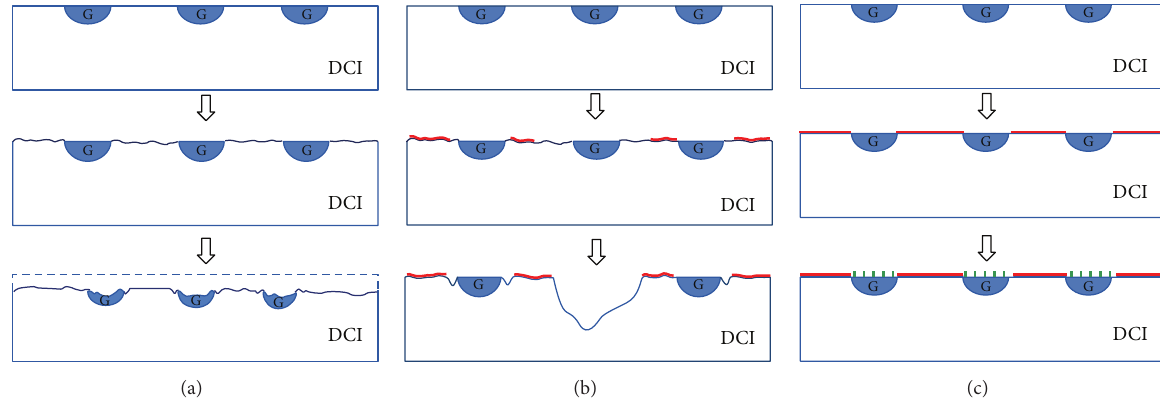
Figure 15: Corrosion and inhibition steps with nitrite addition of ductile cast iron; (a) without corrosion inhibitor, (b) with insufficient corrosion inhibitor (10,000 ppm NaNO 2 ), and with sufficient corrosion inhibitor (100,000 ppm NaNO 2 ) (G; graphite, red line; metallic oxide, dot line; nitrogen compound).